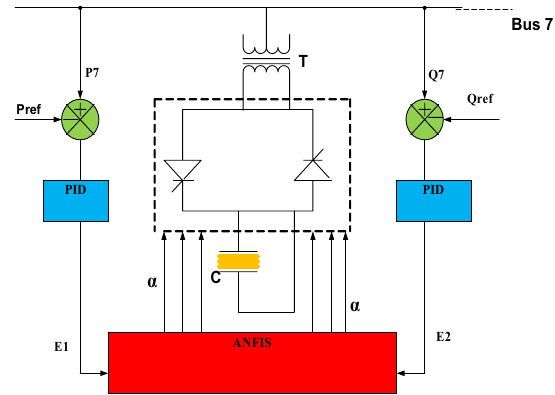
Fig. 17 Switching structure of